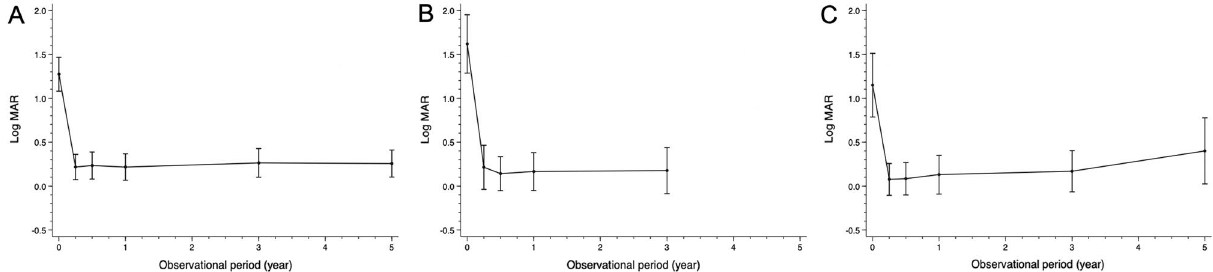
Figure 3. Changes in Visual acuity (VA). ( A ) Acrysof group. ( B ) iSert XY-1 group. ( C ) iSert 251/255 group. A significant improvement in VA (logMAR) is observed after cataract surgery in all groups. However, there is no significant difference in VA among groups at each time point, but slightly better VA is observed in the Acrysof group at 5